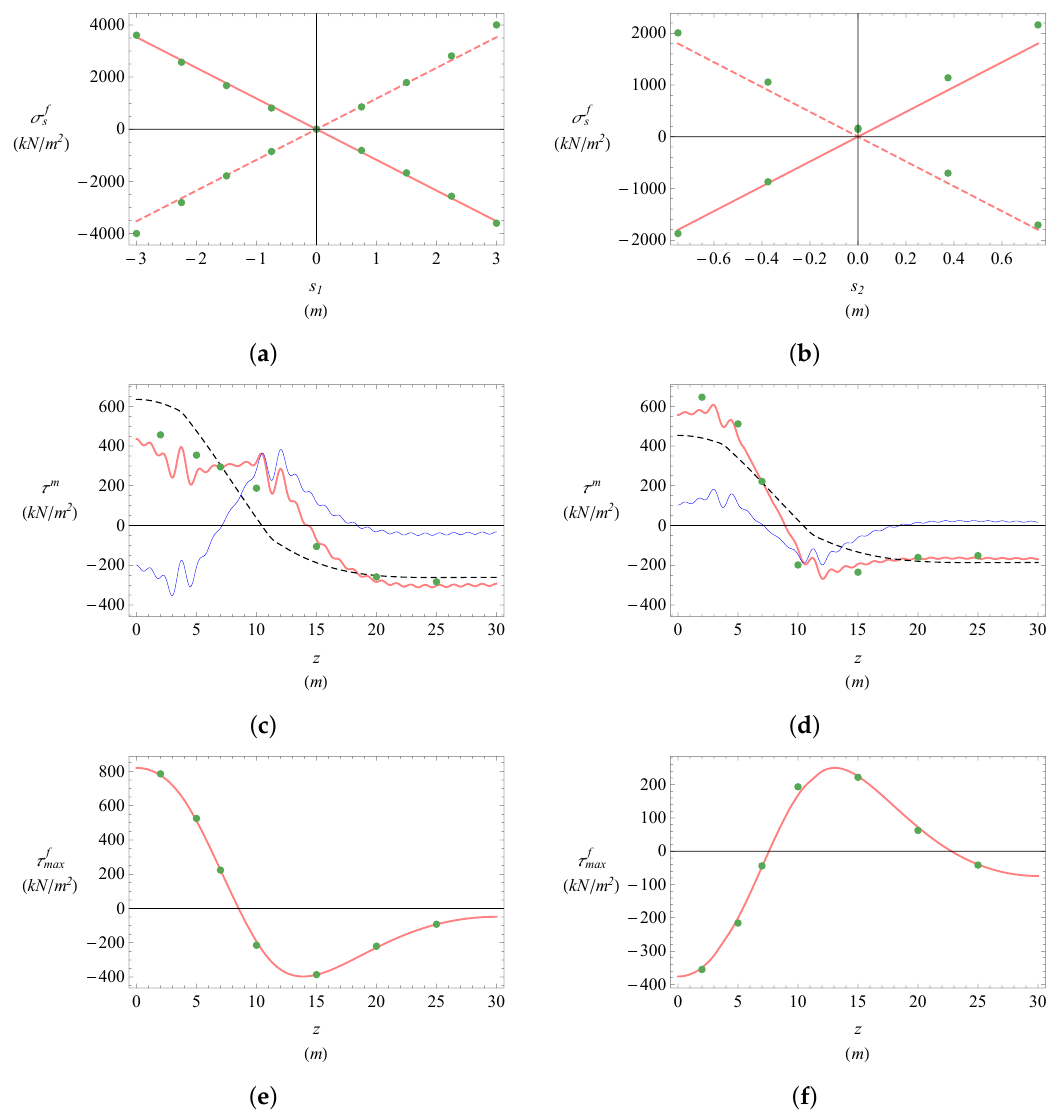
Figure 19. Torsion coupled to distortion: ( a , b ) membrane longitudinal normal stresses evaluated at the corners ( s i = b ( c , d ) active (dashed black line), reactive (blue line), and total (red line) membrane tangential stresses evaluated at half side ( s i = 0); ( e , f ) flexural tangential stresses evaluated at half side ( s i = 0) bottom/top edge ( y i = t i ( b , d , f ) element 2; Fourier analysis with N = 50 terms, FEM analysis (bullets).